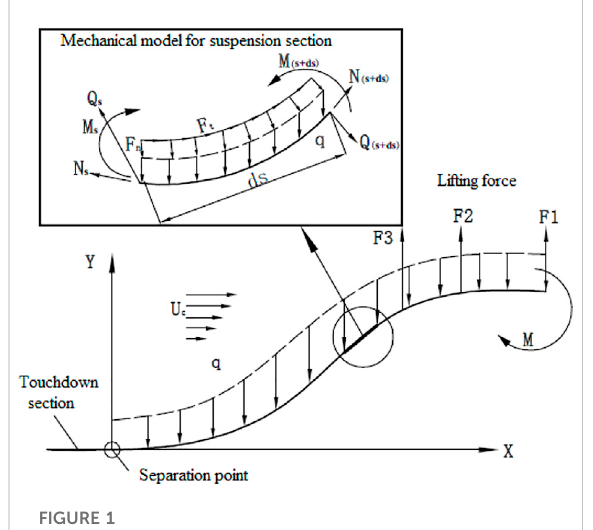
FIGURE 1 Schematic diagram of mechanical analysis of horizontal lifting of subsea pipeline.